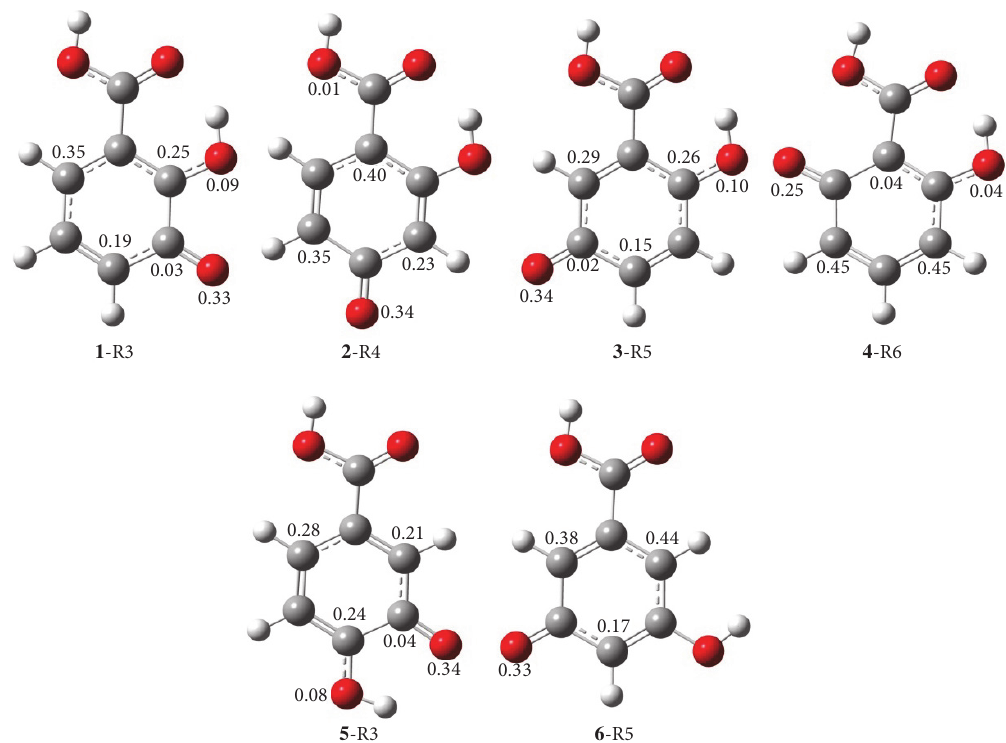
Figure 3: Spin density distribution in all DHBA’s radicals in